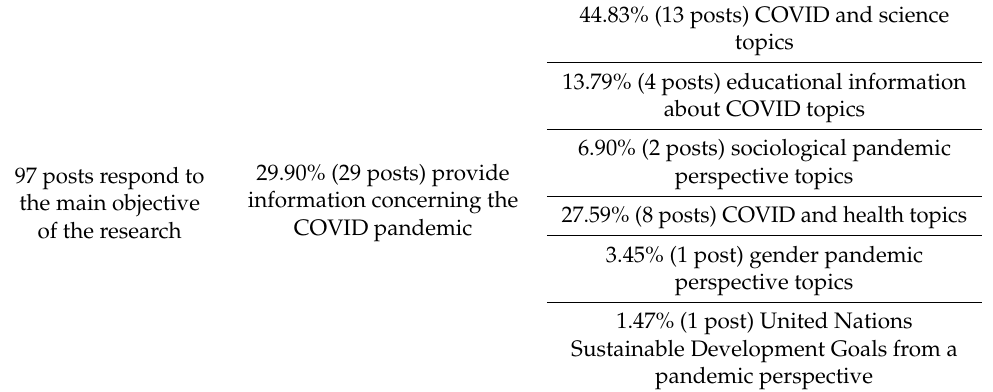
Table 5. Analysis of the